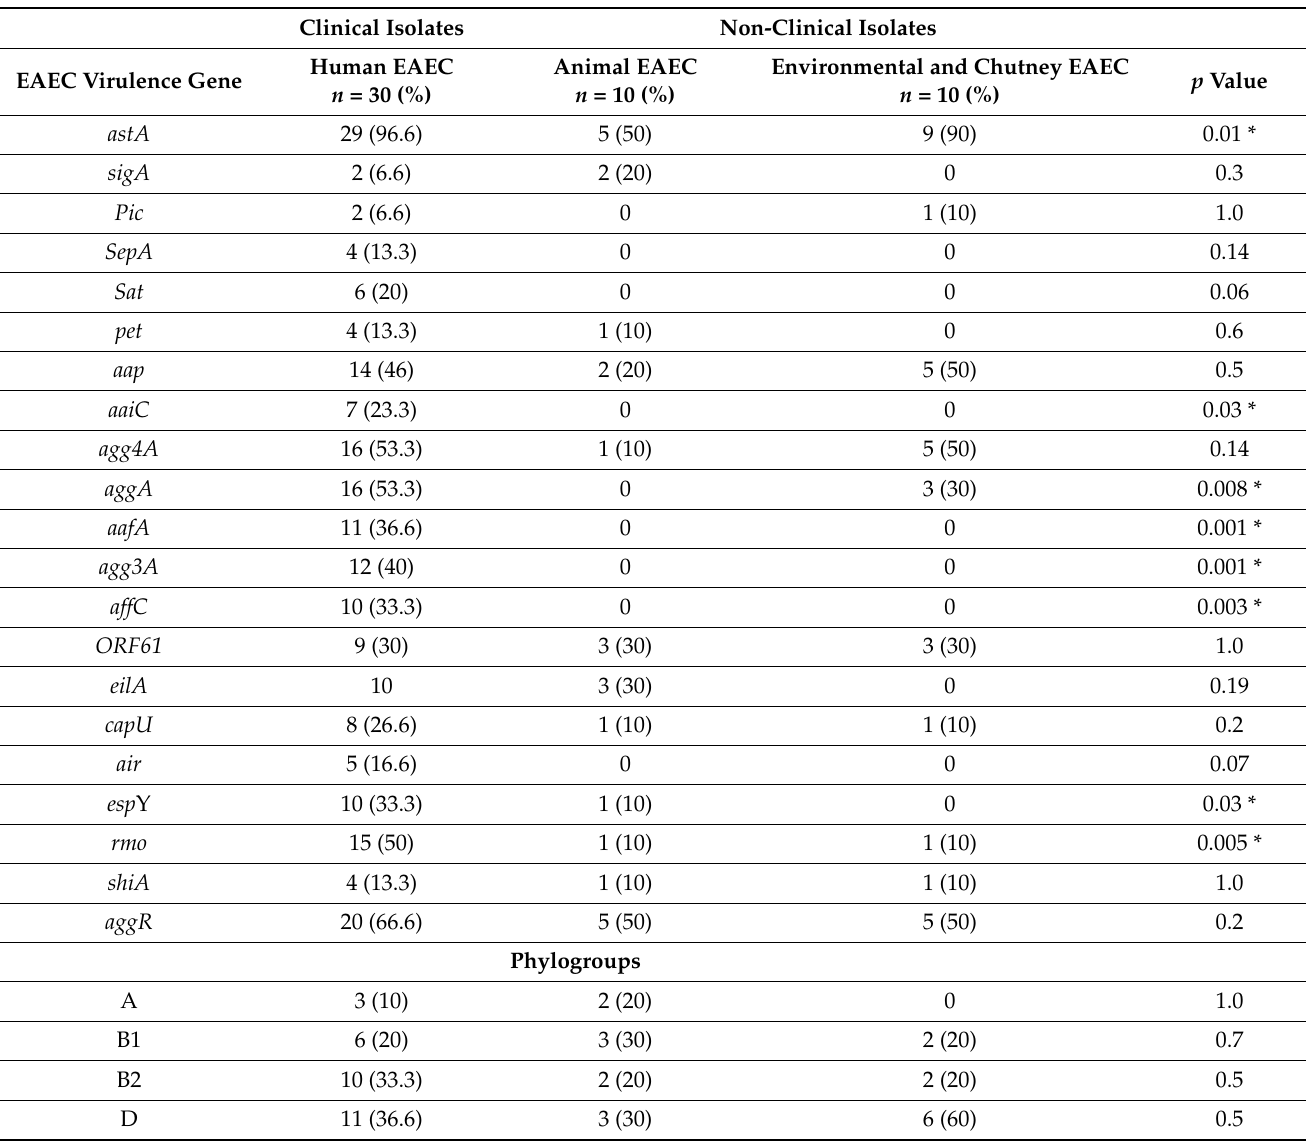
Table 1. Distribution of virulence-related markers and phylogeny among EAEC isolates from clinical and non-clinical sources used in the animal